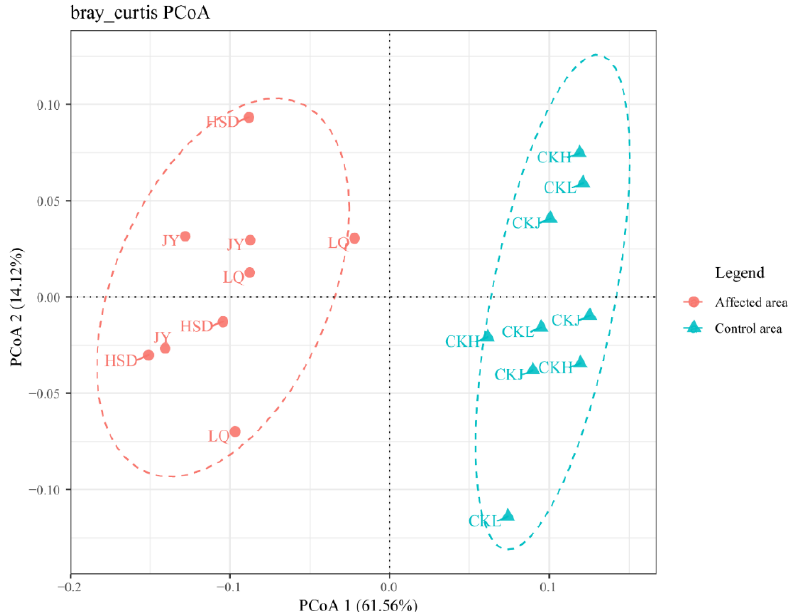
Figure 5. Principal coordinates analysis (PCoA) of the bacterial communities of the three turfy swamps. PCoA 1 and 2 explained 61.56% and 14.12% of the variance, respectively. Points that are closer together on the ordination show communities that are more similar.